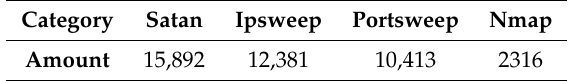
Table 2. The categories we selected in KDD99 (Knowledge Discovery and Data Mining).